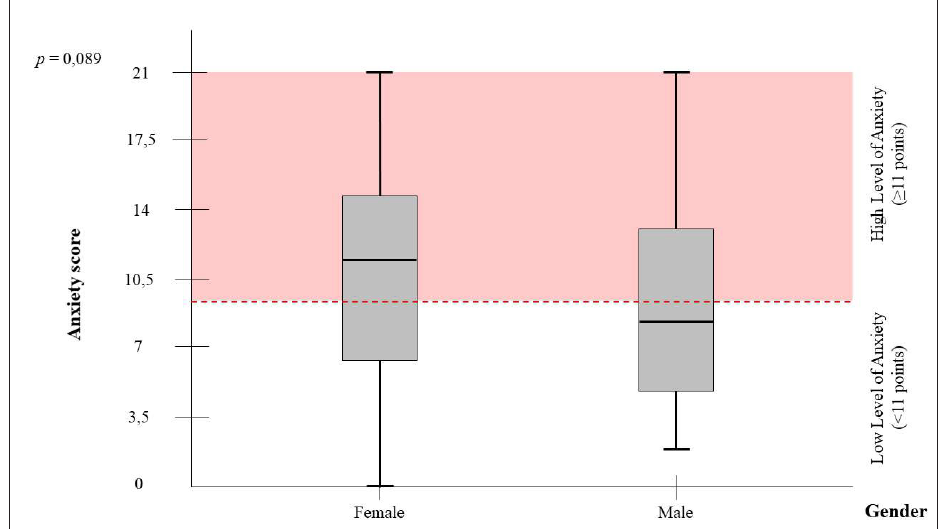
Figure 8. Comparison of Anxiety Levels Between